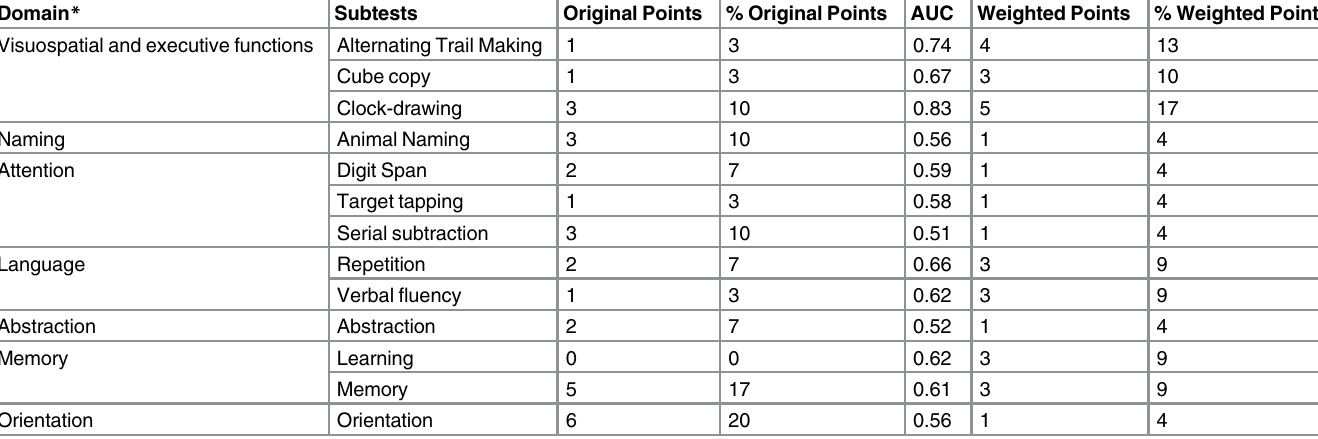
Table 1. AUCs of the MoCA subtests in study 1, original and weighted subtest